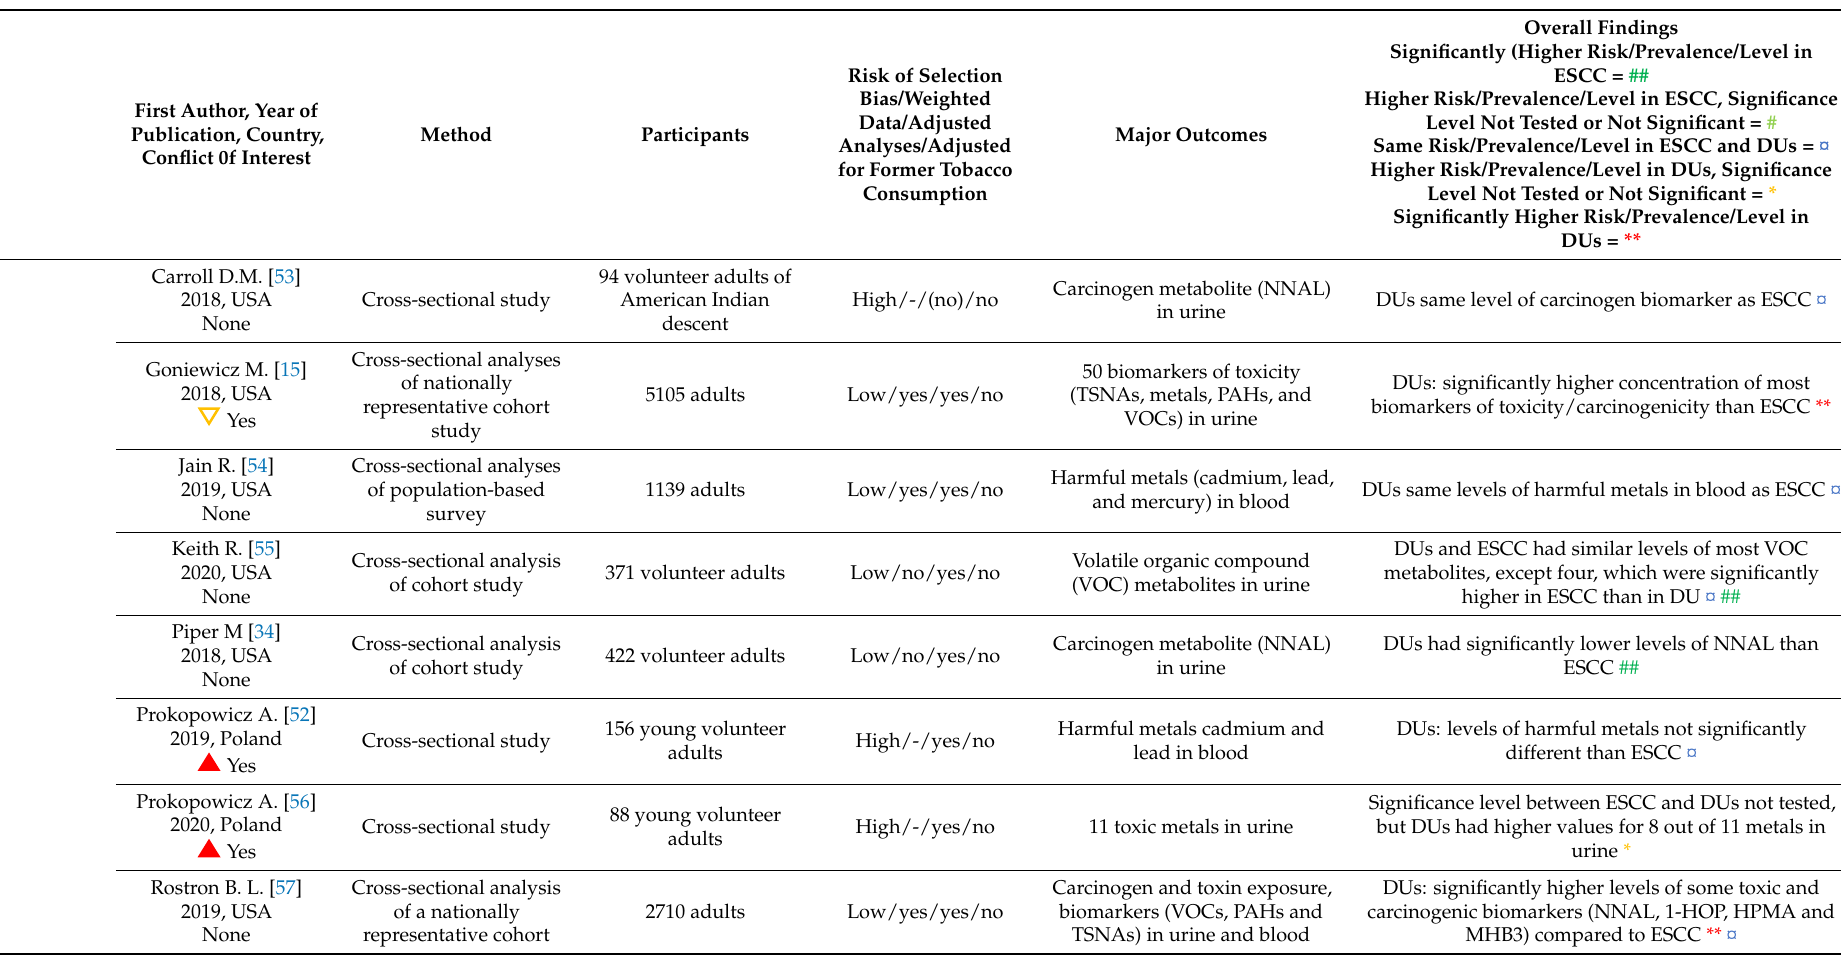
Table 2. Cross-sectional studies investigating potential harm of DUs compared to ESCC.